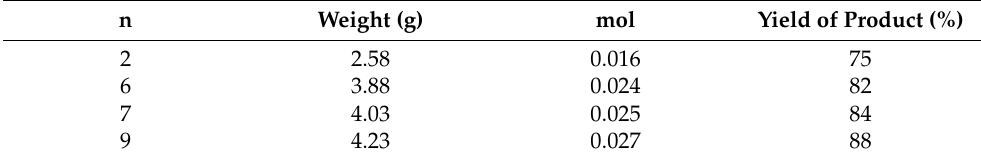
Table 2. Amounts of HMDS for synthesis of linear oligodichlorophosphazenes with general formula